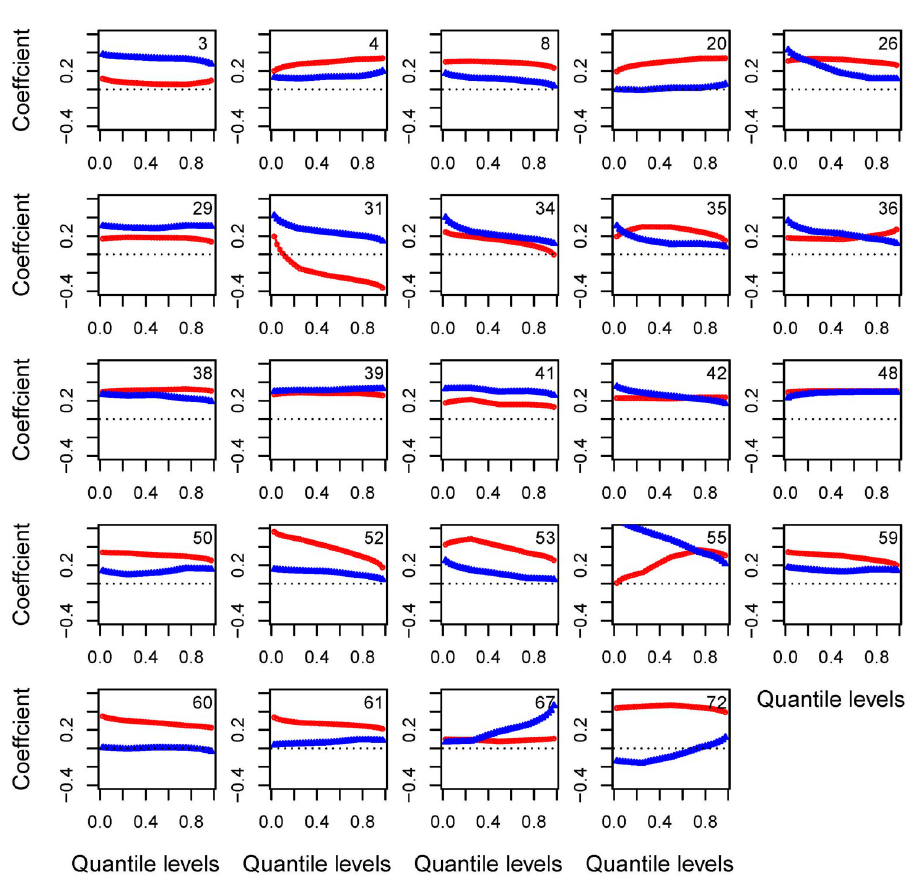
Fig 4. Quantile trend as a function of quantile level for selected stations. The red curve is for Dmx and the blue curve for Dmn. The horizontal dashed line represents coefficient being zero.